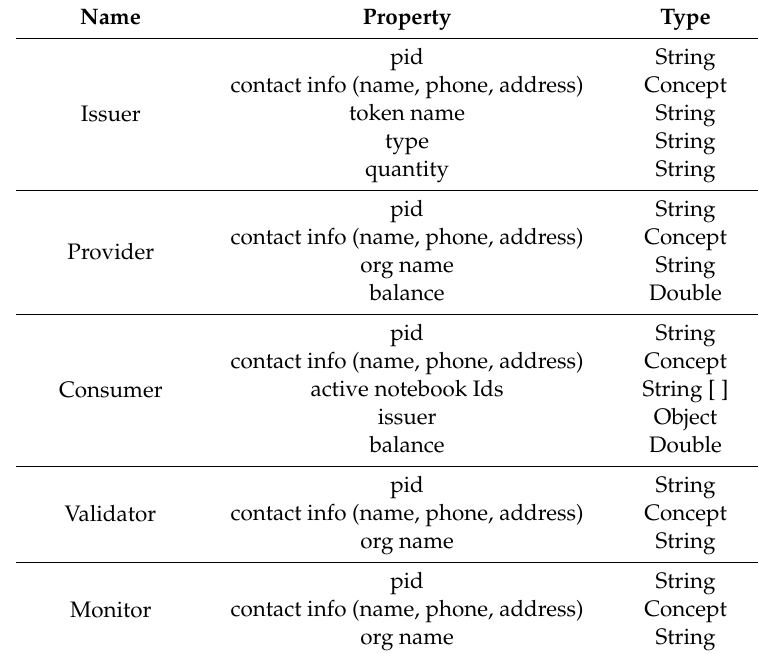
Table 1. Participant definition in the smart contract.